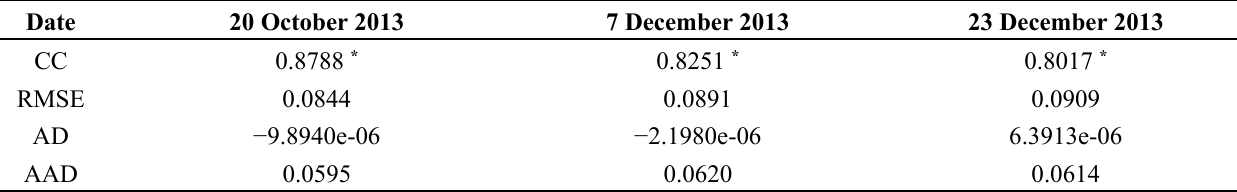
Figure 6. Thermal spatial sharpening results of simulated experiments using ELM algorithm. False colour images of observed Landsat ETM+ multispectral data at 30 m ( upper row ), TIR images at 60 m ( middle row ) and Enhanced TIR images at 30 m ( lower row ). From left to right, they were acquired on 20 October, 7 December and 23 December 2013. Table 1. Quantitative assessment of thermal sharpening in the testing experiment via